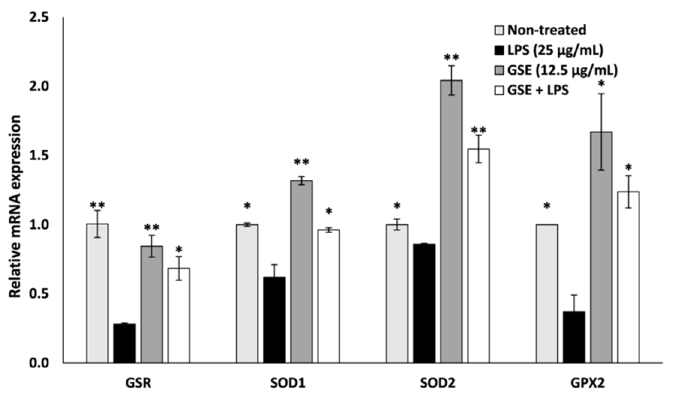
Figure 3. Effect of GSE on oxidative stress-related gene expression in LPS-induced Caco-2 cells. Relative expression of antioxidant genes Glutathione-Disulfide Reductase (GSR), Superoxide Dismutase 1 (SOD1), Superoxide Dismutase 2 (SOD2), and Glutathione Peroxidase 2 (GPX2) was significantly decreased in LPS-treated Caco-2 cells compared to untreated control, and expression was restored upon treatment with GSE. Error bars indicate ± S.D. ( n = 3). * and ** indicate the data were significantly different relative to LPS-treated cells with p ≤ 0.05 and p ≤ 0.01 respectively using Tukey’s test.